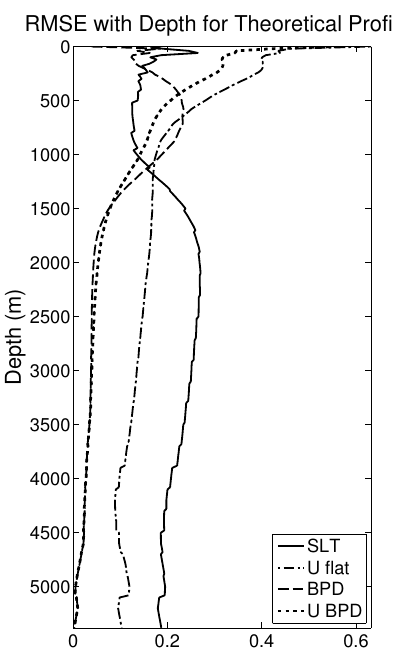
Fig. 11. Root mean square error of the theoretical sections com- pared to the mean model section as a function of